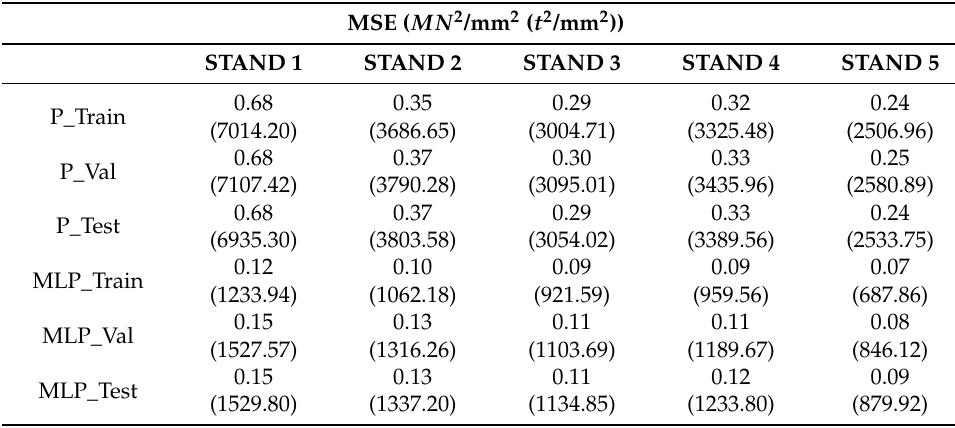
Table 13. Comparison of the the roll force prediction using